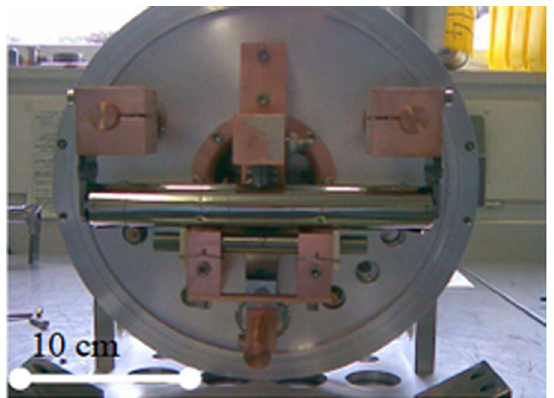
FIG. 4. Configuration of the neutron converter (tungsten cylinder and beryllium oxide target used for on-line tests at CERN-ISOLDE).